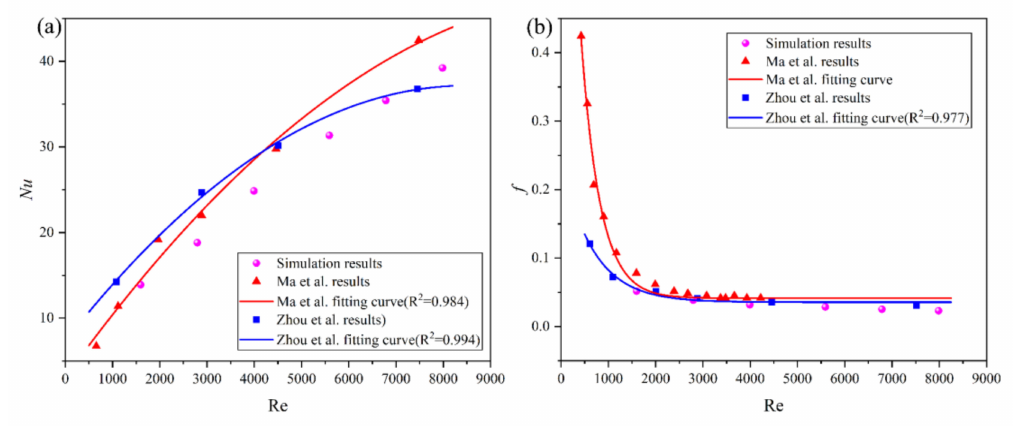
Figure 3. Validation of numerical results ( a ) Nu , ( b ) f